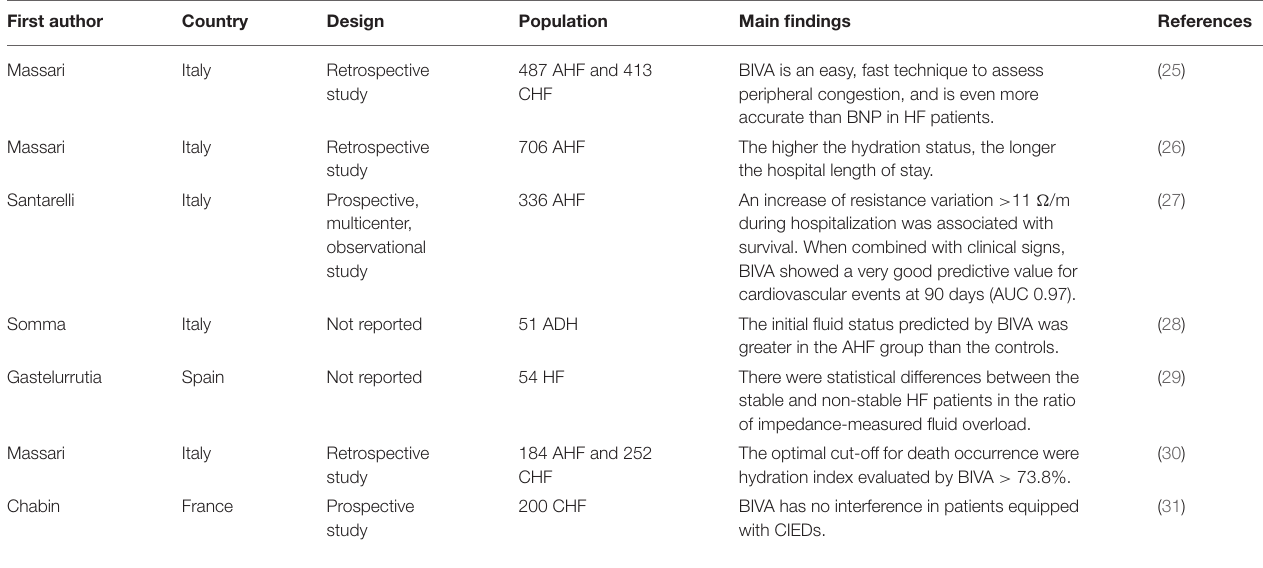
TABLE 1 | Summary of main